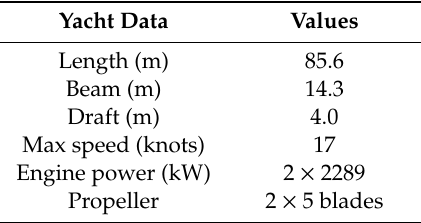
Table 2. Motor-yacht